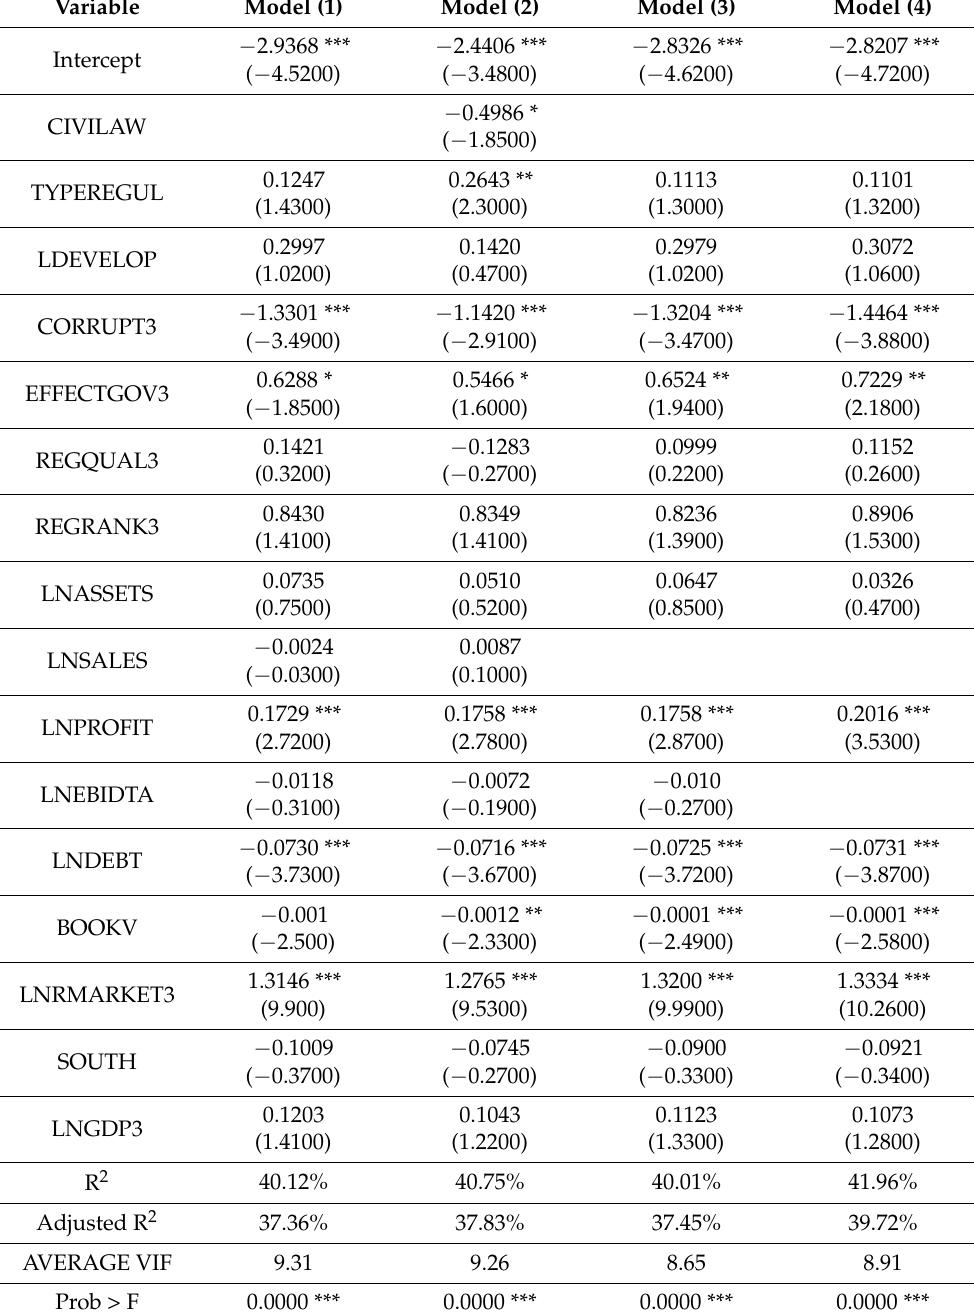
Table 7. Three-year return—LNBHR3—results